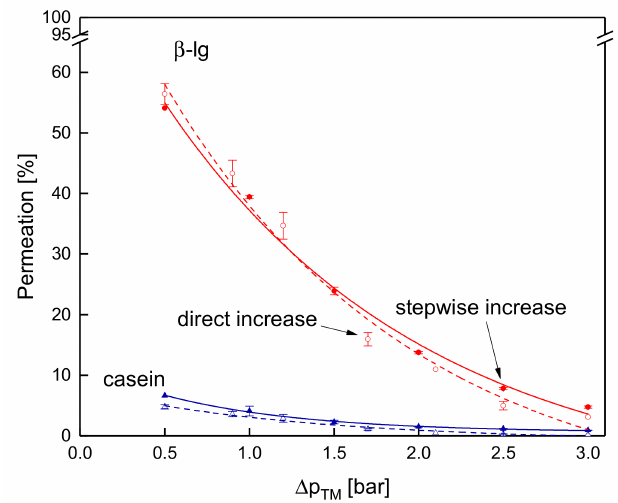
Figure 9. Permeation of β -lg (circles) and casein (triangles) at 10 ◦ C measured with the stepwise increase (filled symbols and solid lines) and direct pressure increase to target level (blank symbols and dashed